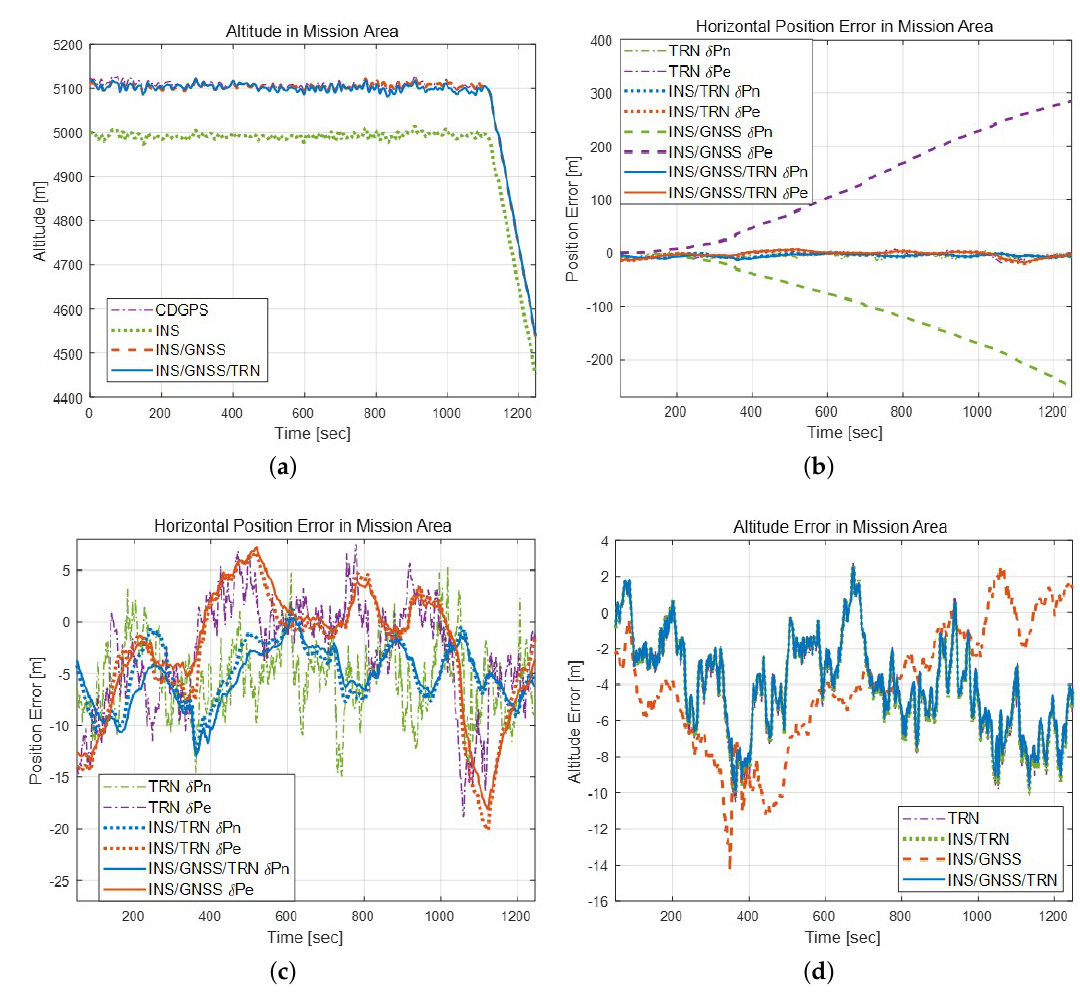
Figure 14. Results of CFT 2 when GNSS is unavailable in the mission area. ( a ) Attitude profile. ( b ) Horizontal position error. ( c ) Horizontal position error without INS/GNSS-aided navigation error. ( d ) Altitude